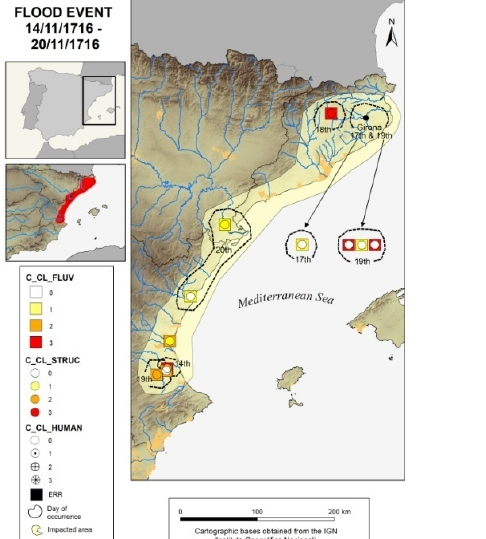
Figure 2. ( Left ): Representation of cases for the flood event of 2 November 1617. ( Right ): Representation of cases for the flood event of 3 November 1617. C_CL_FLUV: Variable 1. Hydraulic behaviour of the river flood. C_CL_STRUC: Variable 2. Flood impact on structural elements. C_CL_HUMAN: Variable 3. Social/personal vulnerability to the flood. ERR: Erroneous or spurious cases. Blue line: Basic fluvial system. Black line: Spanish Hydrographic Demarcations. Urban areas: Population according to 2022 demographic record.